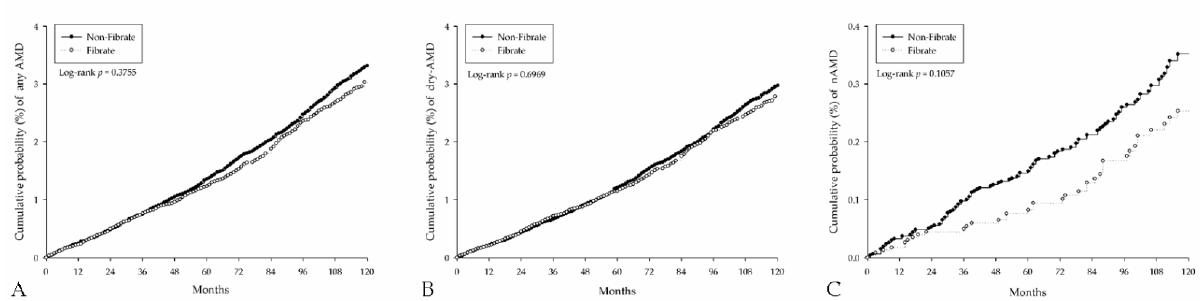
Figure 3. The Kaplan-Meier curves for the incidence of age-related macular degeneration. ( A ) Incidence of any types of age-related macular degeneration. ( B ) Incidence of dry age-related macular degeneration. ( C ) Incidence of neovascular age-related macular degeneration.